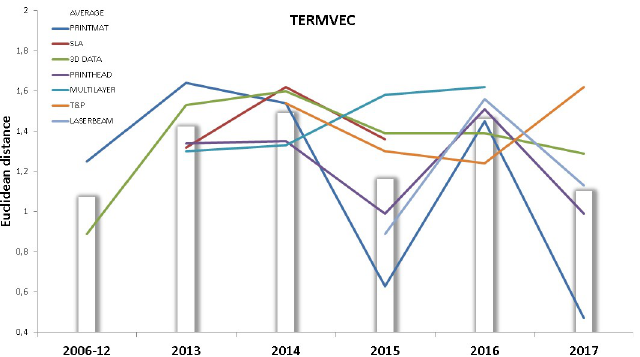
Fig 16. TERMVEC for each technology front. This figure shows the evolution of the TERMVEC indicator for each technology front. Data points above the bars indicate higher than average Euclidean distance between term vectors.